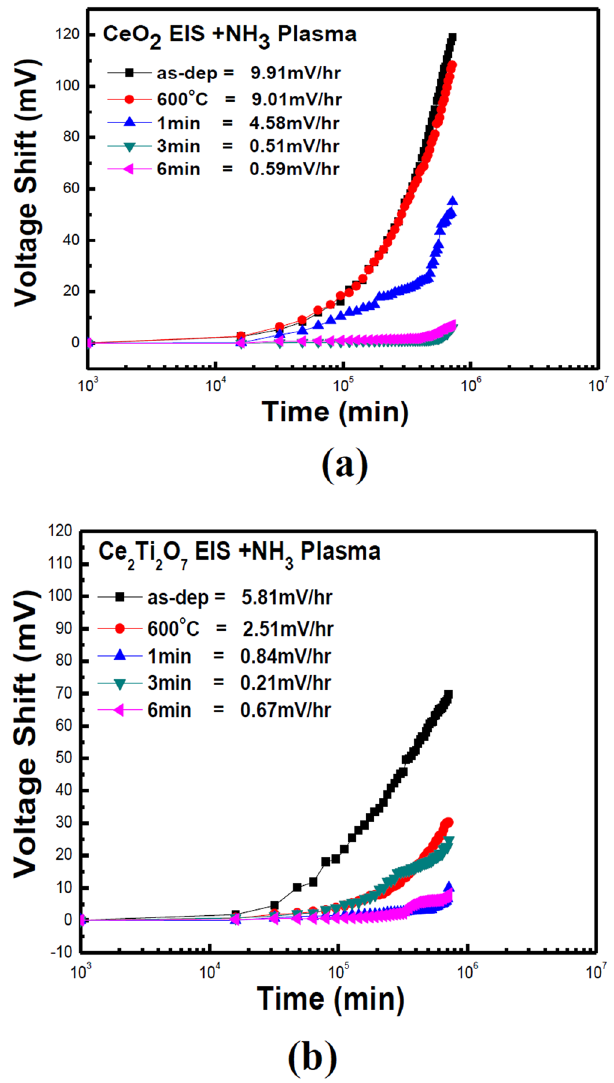
Figure 9. The drift voltage of ( a ) CeO 2 and ( b ) Ce 2 Ti 2 O 7 sensing membrane with NH 3 plasma treatment in various conditions and then dipped in pH7 buffer solution for 12